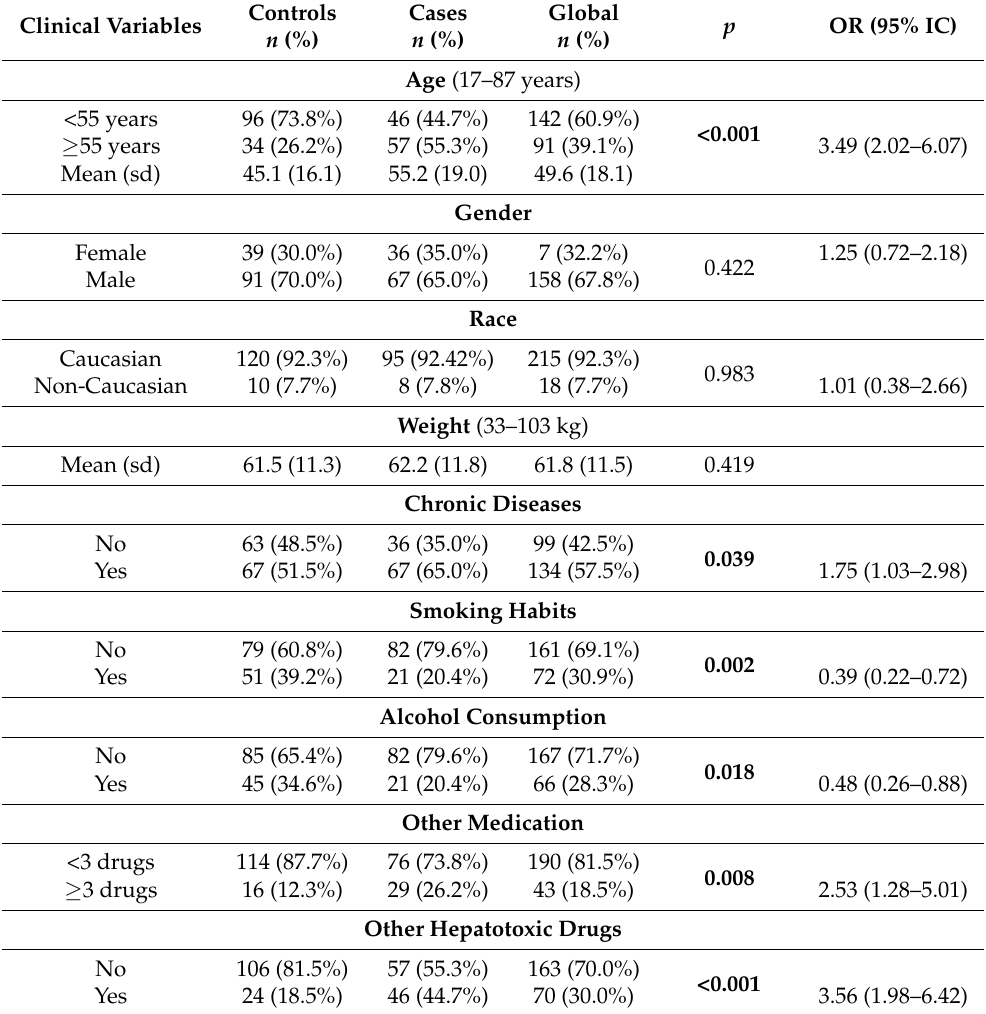
Table 2. Characterization of non-genetic risk factors. Clinical Variables